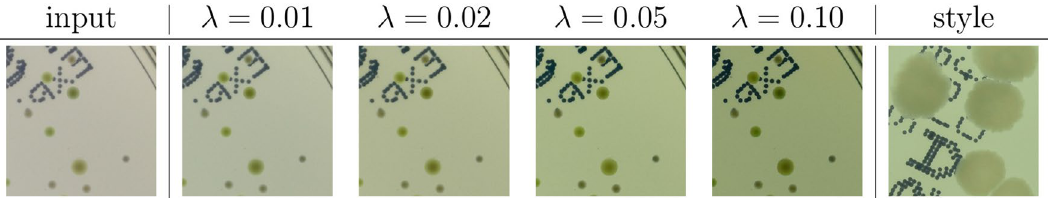
Figure 4. Image style transfer for different stylization weights. Style (right) is transferred to input content image (left) with different stylization amount (middle) tuned by (cid:31)